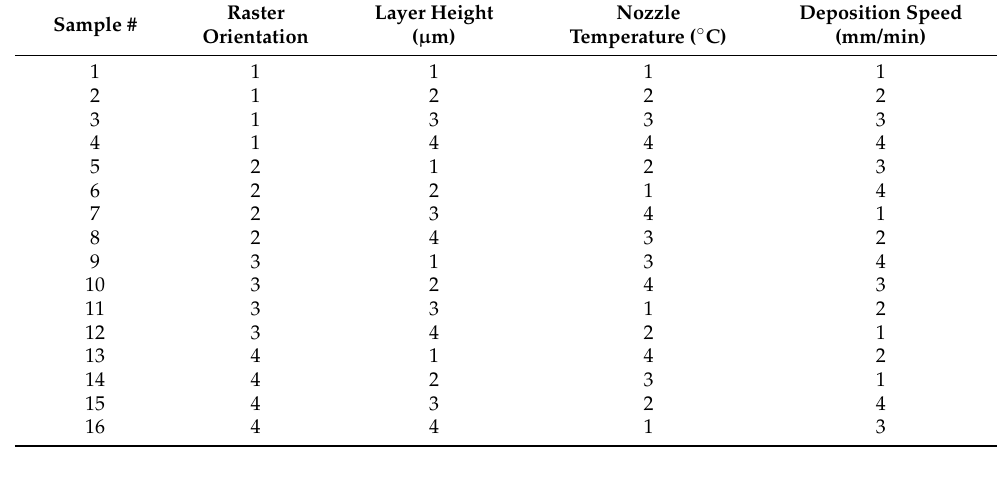
Table 3. Orthogonal array used to design the experimental layout with respect to configuration levels given in Table 2.